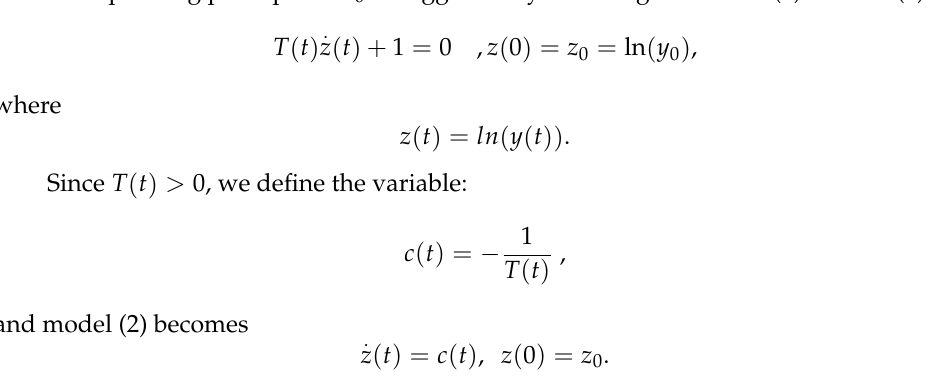
Figure 1. The block diagram of the continuous-time observation structure of the parameter T .